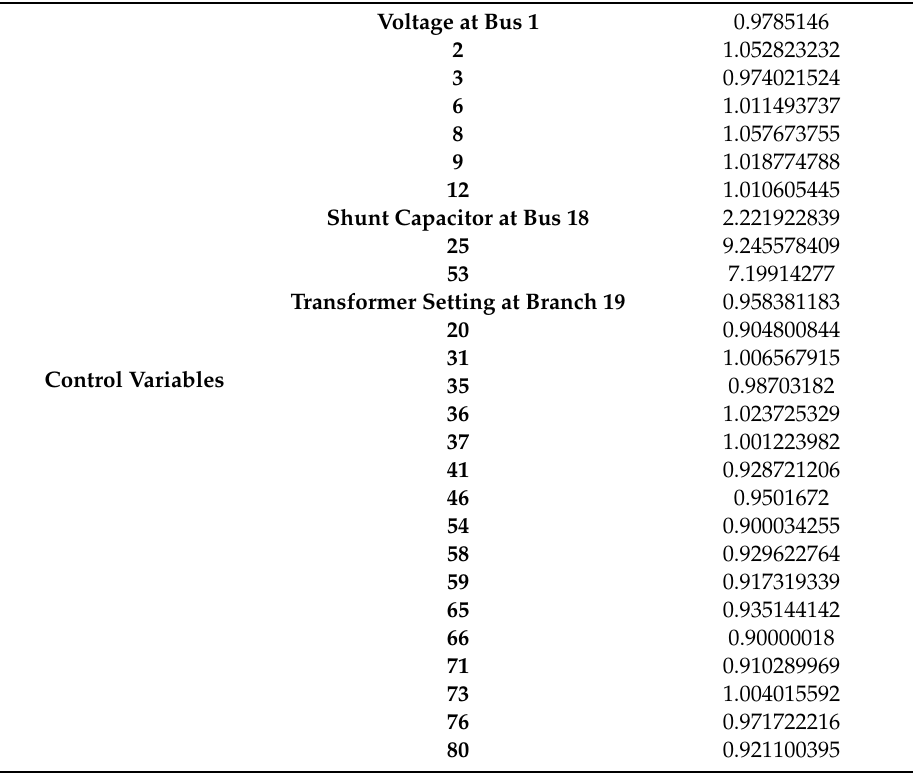
Table 6. 57-bus system decision variables for the first case.